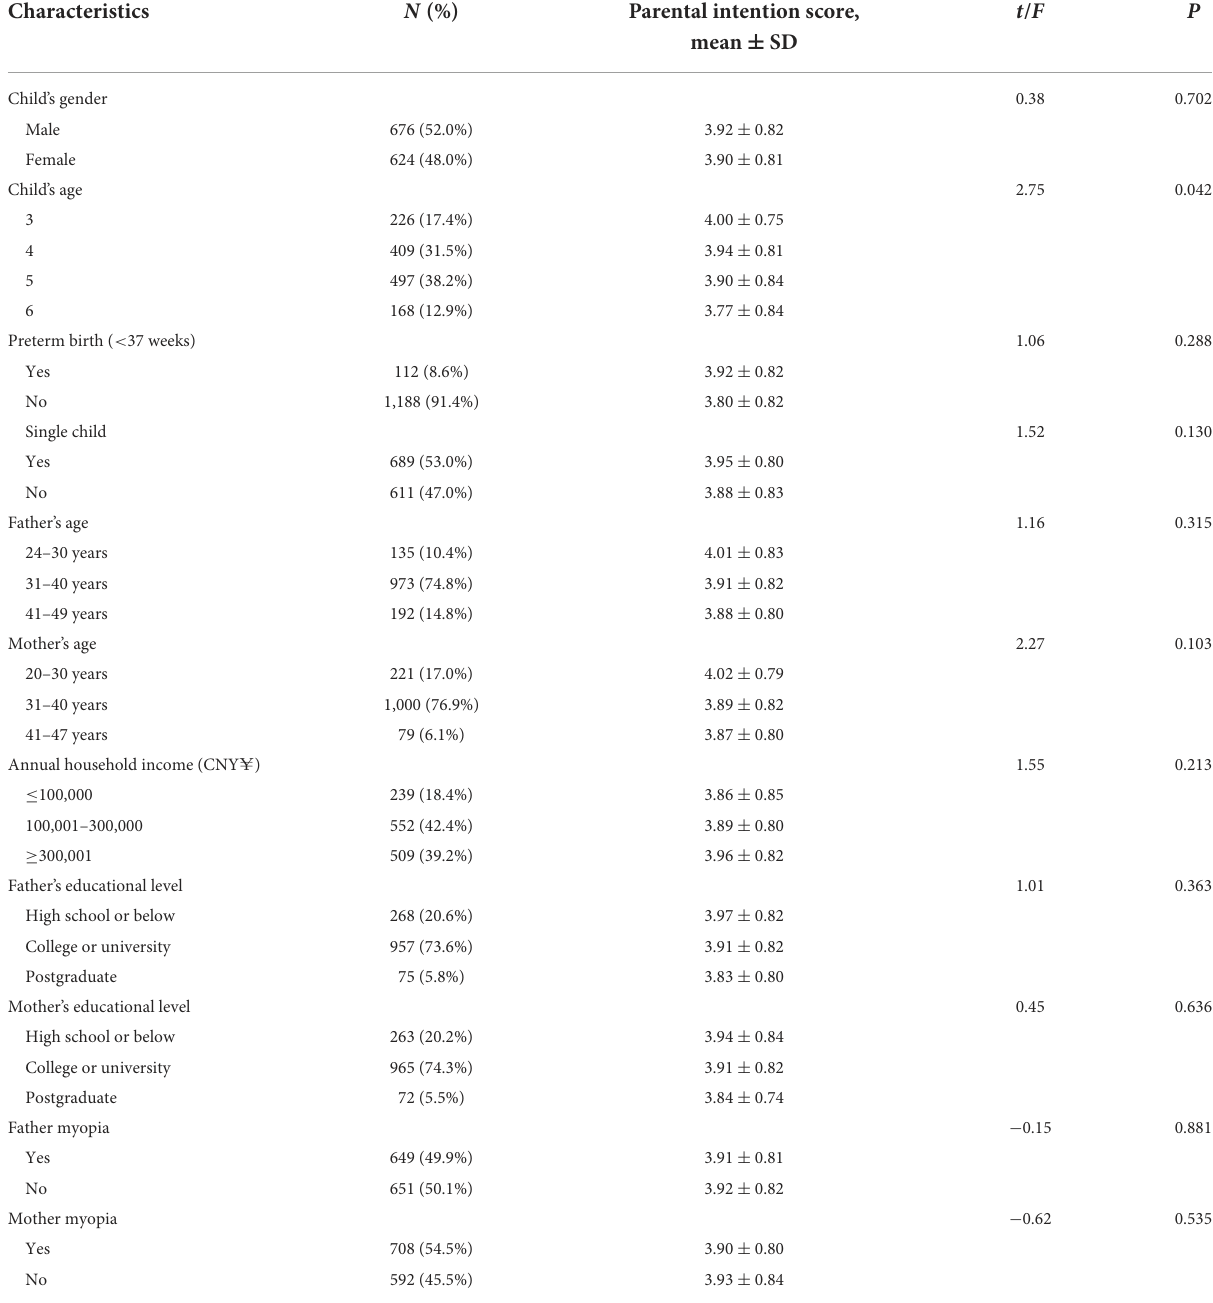
TABLE 2 Relationships between the parents’ intentions scores and socio-demographic characteristics for children and parents ( n = 1,300). Characteristics N